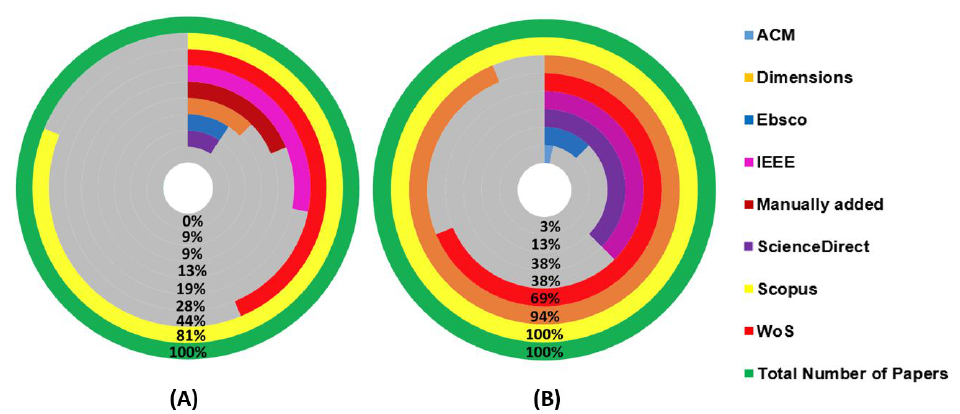
Figure 4. ( A ) Number of articles found by the search string in each database; ( B ) number of selected articles that could have been found in each database (search string + manual search).